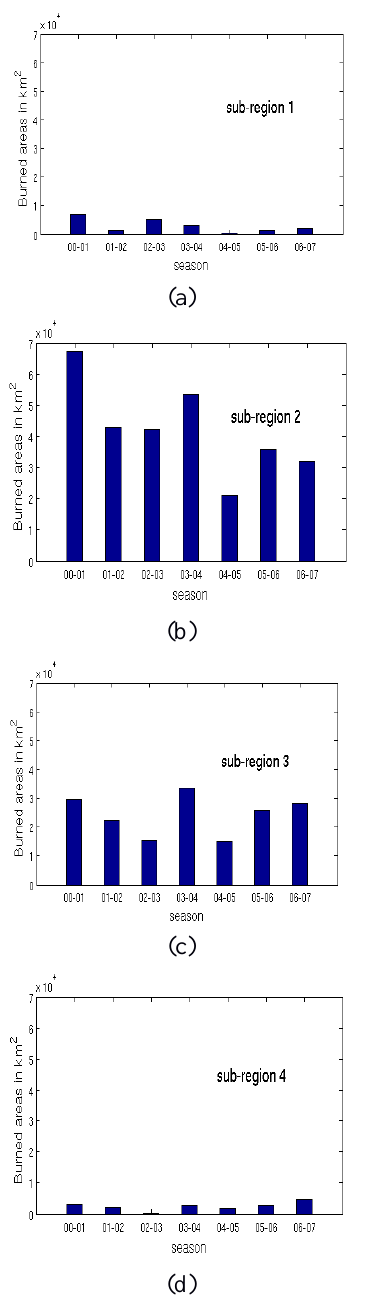
Figure 7. The interannual variability in burned areas for the four West African subregions: (a) subregion 1, (b) subregion 2, (c) sub- region 3 and (d) subregion 4.